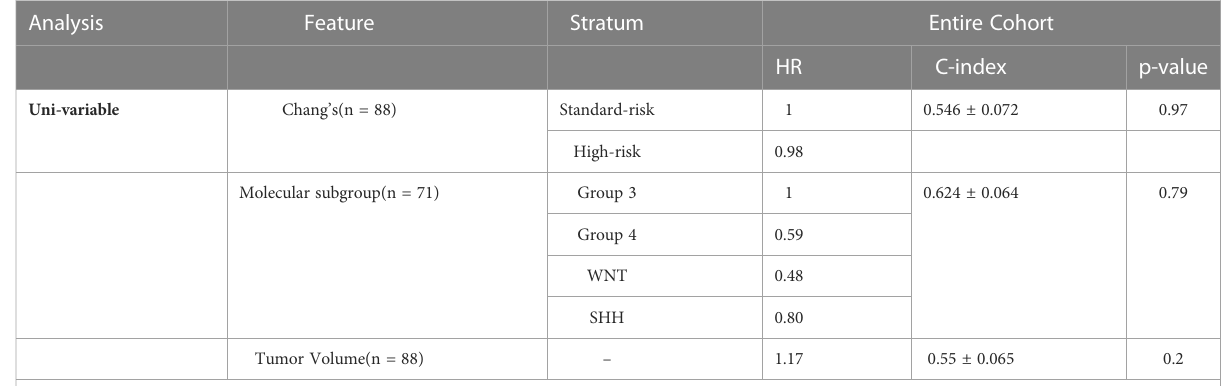
TABLE 3 p-value, concordance indices, and hazard ratios for the survival experiments conducted in a univariate setting using Chang ’ s classi fi cation, molecular subgroup information, and the tumor volume information. Analysis Feature Stratum